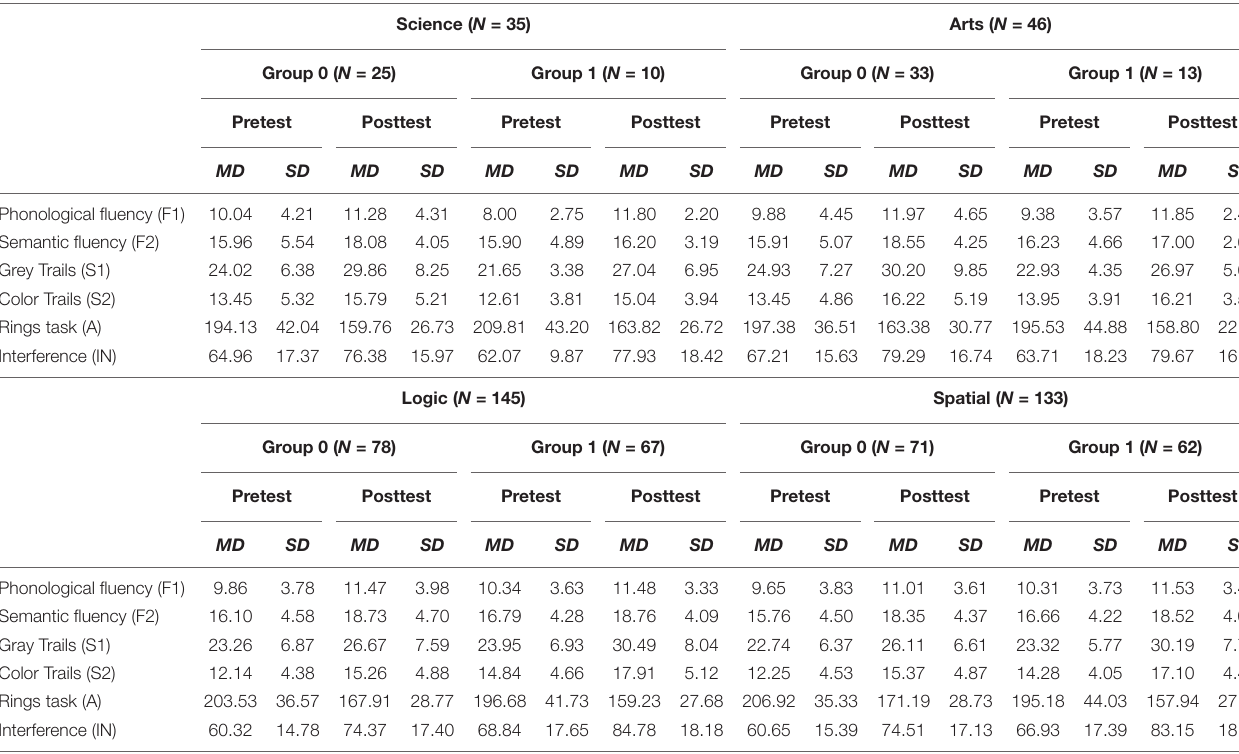
TABLE 2 | Descriptive statistics of children by groups created for the post hoc